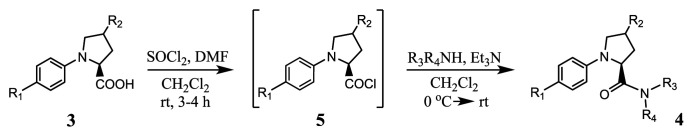
Synthetic route to N-(4′-nitrophenyl)-l-prolinamides.